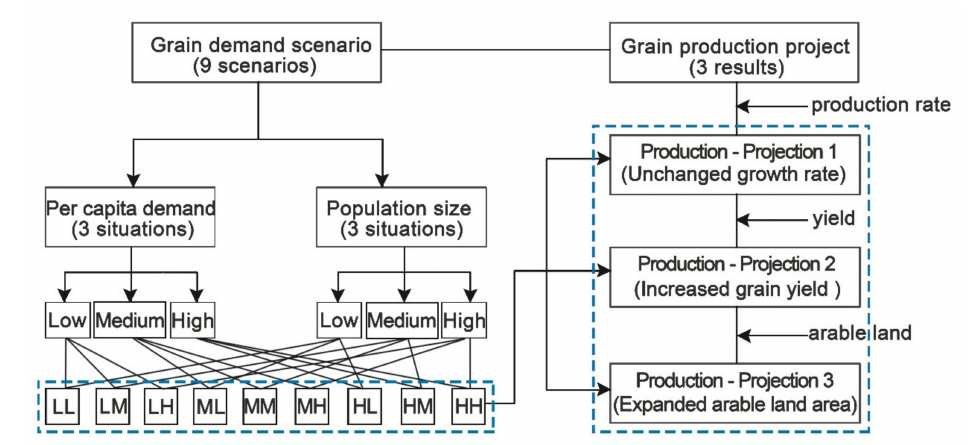
Figure 2. The analysis framework of grain demand scenarios and production